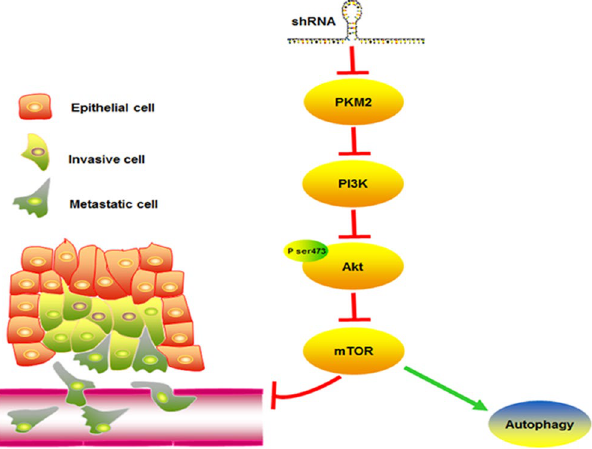
Figure 7. Schematic diagram of the effect of PKM2 on GC and the related pathways. Knockdown of PKM2 could inhibit the PI3K-Akt-mTOR signaling pathway, which induced the autophagy activation and reduced cancer cell migration in human gastric